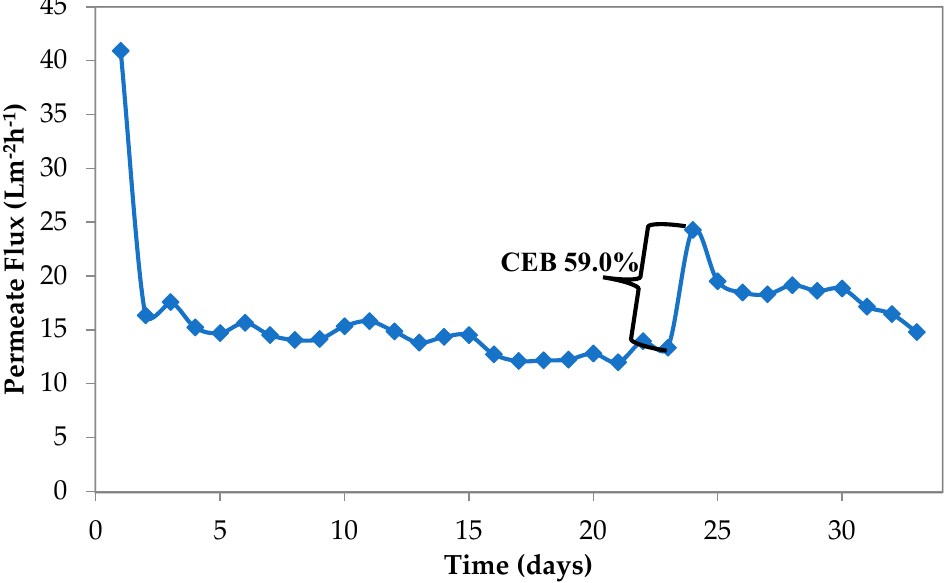
Figure 2. Temperature corrected flux versus time plot obtained at high AS concentration (40 mg/L AS-1 and low MLSS of 10–13 g/L).